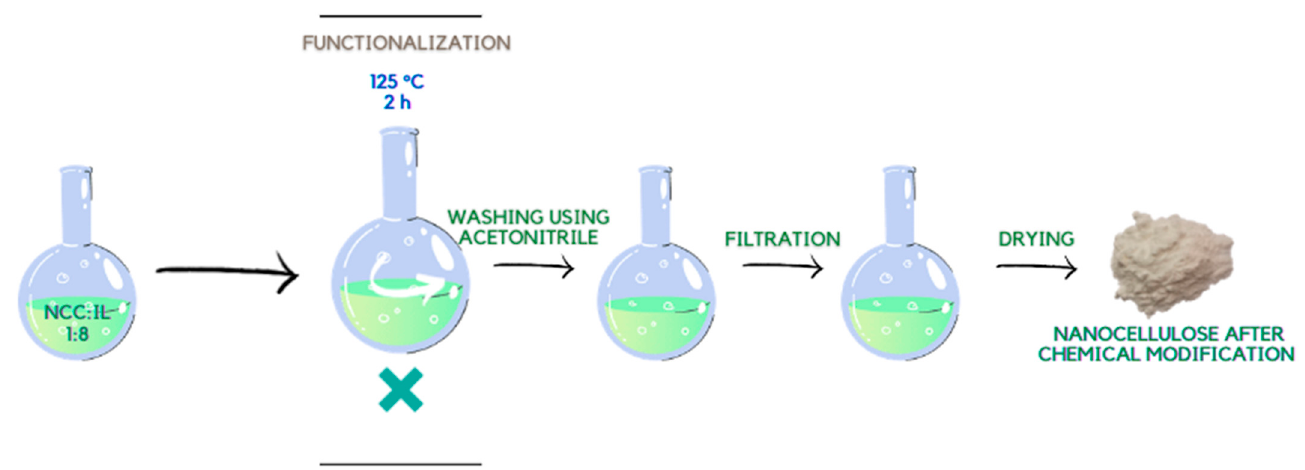
Figure 10. Scheme of chemical modification of nanocellulose using IL’s.